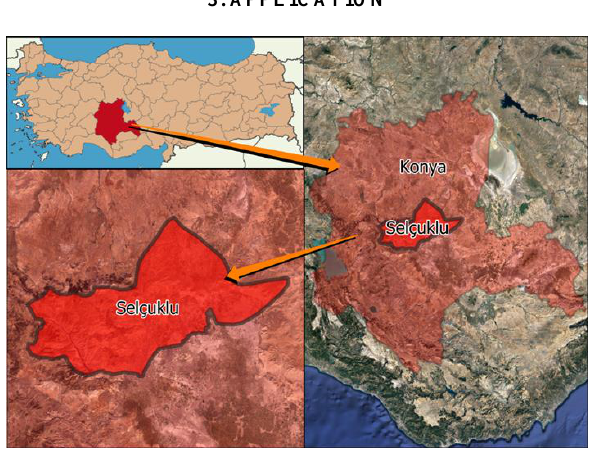
Figure 1. The study area